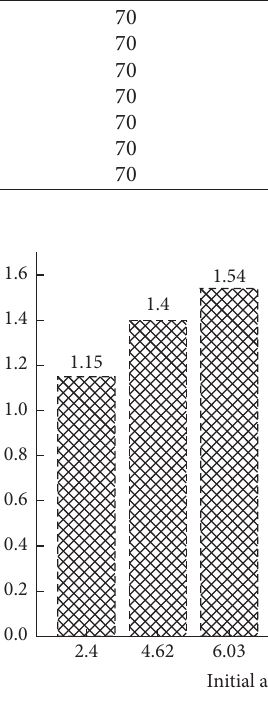
Figure 5: The relationship between initial UCS with different initial air content air content and 28d age